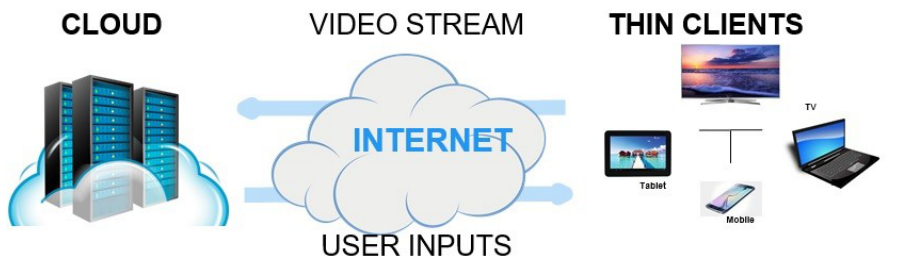
Figure 1. Cloud gaming model.